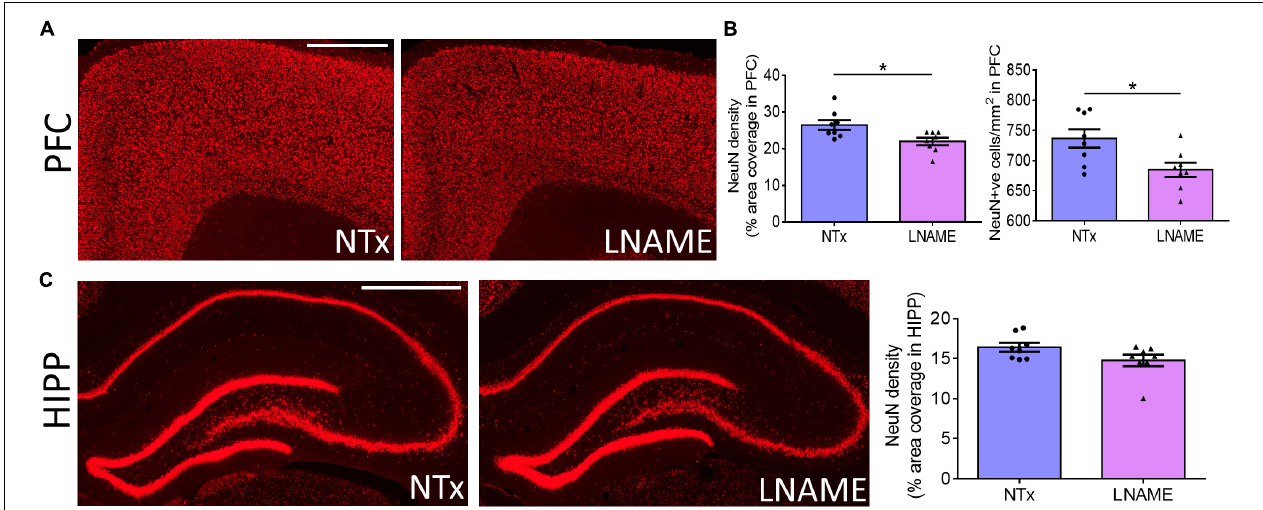
FIGURE 5 | Transient hypertension promotes irreversible loss of neuronal density. (A) Representative images of NeuN fluorescence coverage in PFC; scale bar = 750 µ m. (B) Quantification of NeuN fluorescence coverage (left) and number of NeuN-positive cells (right) in PFC: L-NAME treatment decreased both coverage of NeuN immunoreactivity ( p = 0.017) and number of NeuN-positive cells ( p = 0.017). (C) Representative images (left and middle) and quantification (right) of NeuN fluorescence coverage in HIPP: L-NAME treatment induced a small but statistically insignificant decrease of NeuN coverage ( p = 0.093); scale bar = 1,000 µ m. * denotes p < 0.05; n = 8 rats per